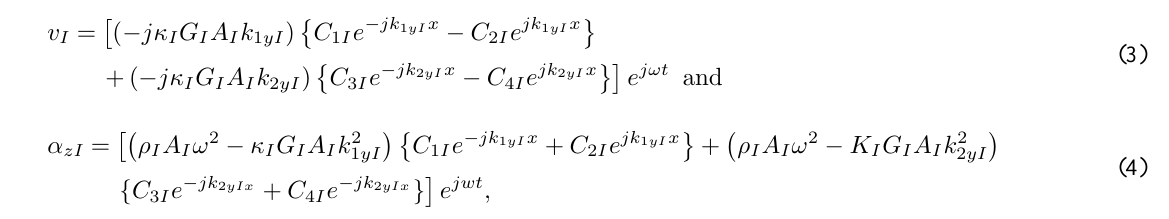
Fig. 2. The sign convention of the shear forces and moments of two Timoshenko beams coupled in three-dimensional joint. By Eq. (1), the y-directional transverse displacement v I and the angle of rotation about z-axis due to bending moment α zI in the incident beam can be represented